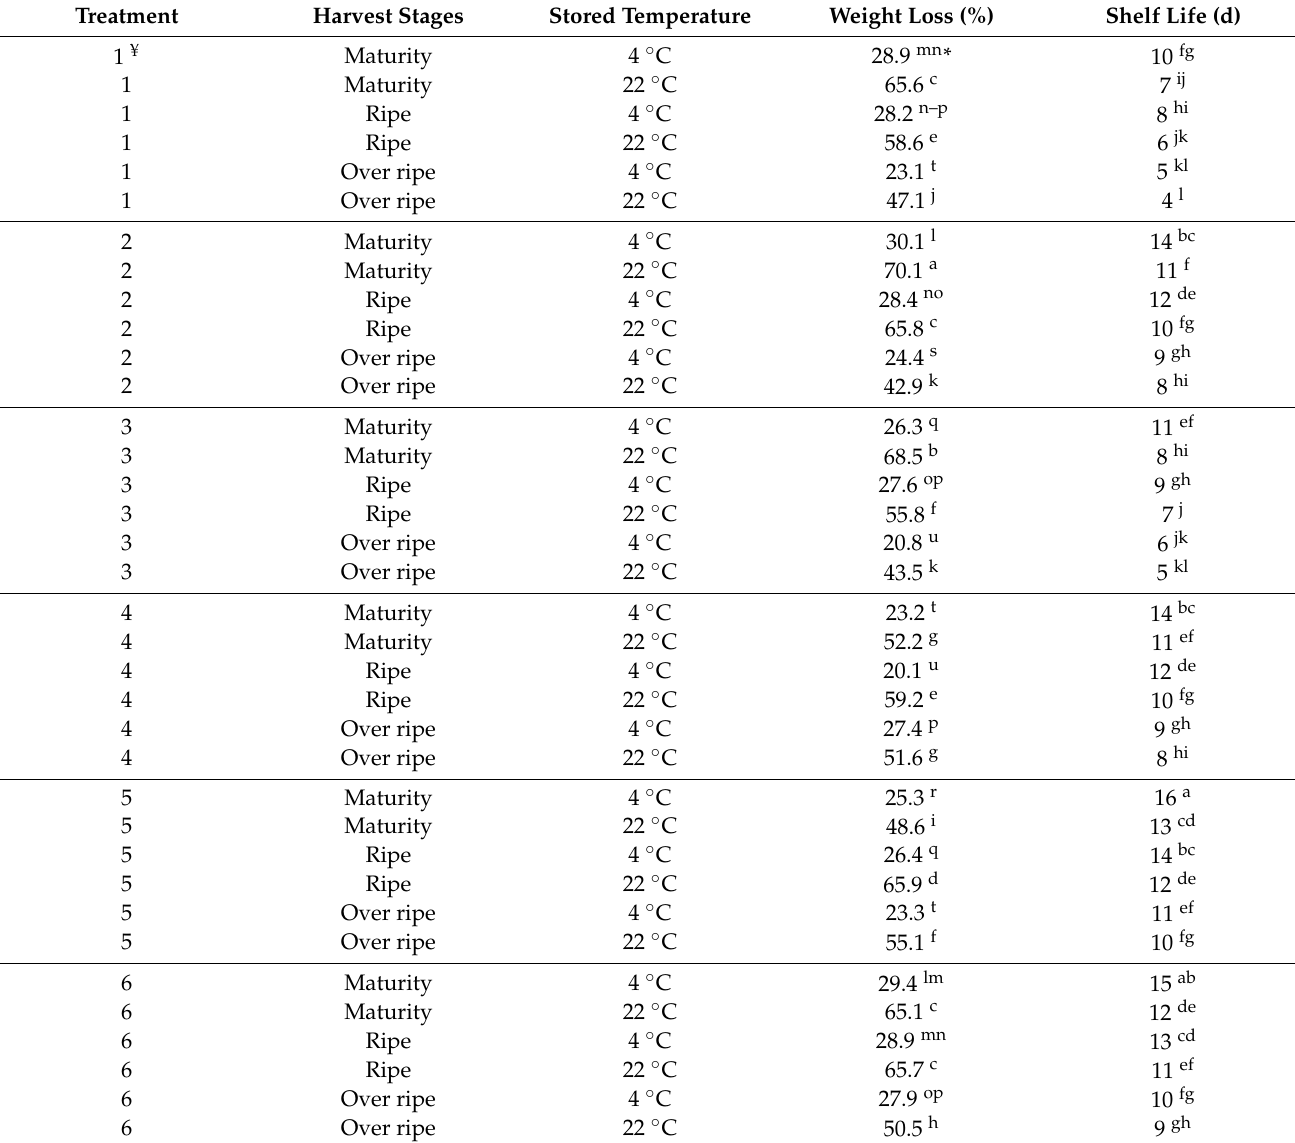
negative correlation ( p < 0.05) was detected between Ca and K, starch and K, starch and P, firmness and K, weight loss and sugar (Table 6). The highest relationship was determined between fruit shelf life and starch (r = 0.87). Table 4. The combined effects of color nets, harvest stages and stored temperature on fresh figs weight loss and shelf life. Treatment